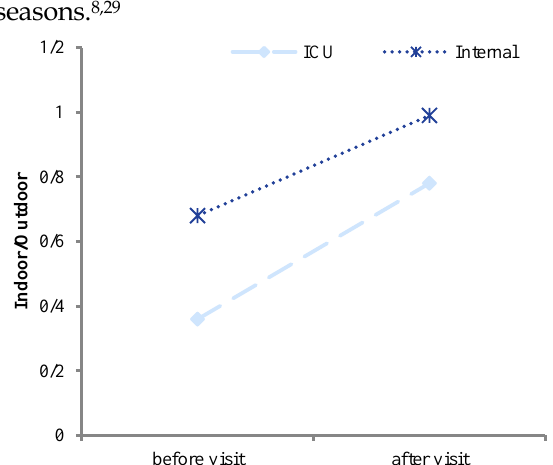
Figure 3. The ratio of indoor to outdoor average fungi in the internal ward, and intensive care units (ICU) of the hospital In this survey, the highest amount of fungi (both indoors and outdoors) was observed in